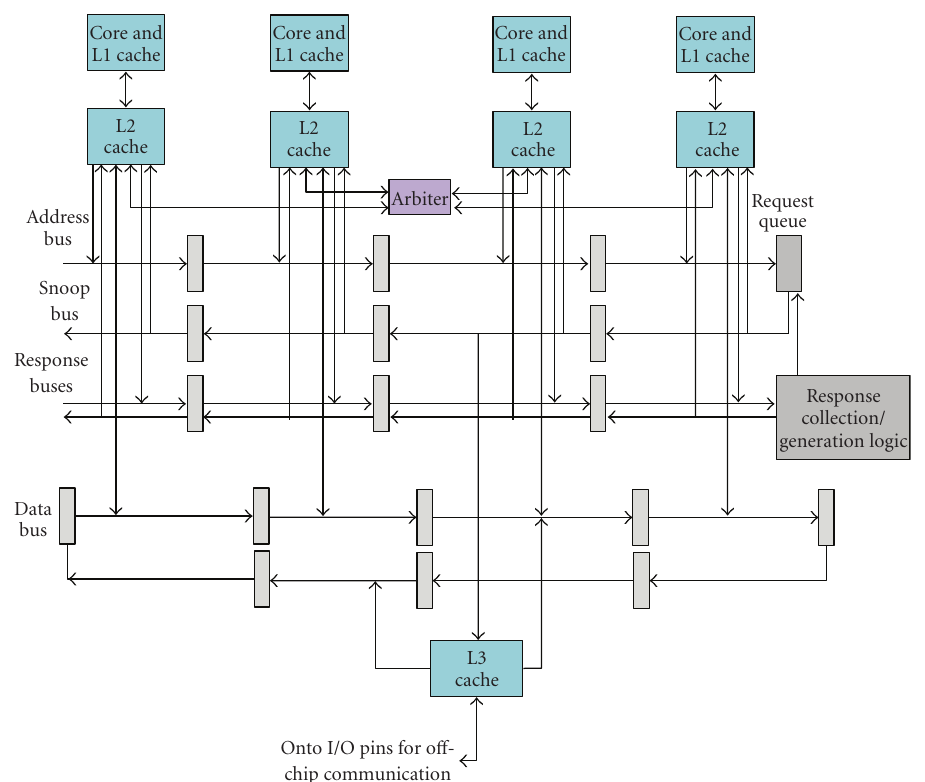
Figure 5: Detailed model of a shared-bus interconnect for